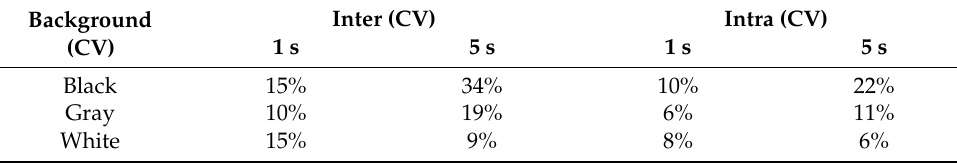
Table 5. Observer variability of color difference estimation.